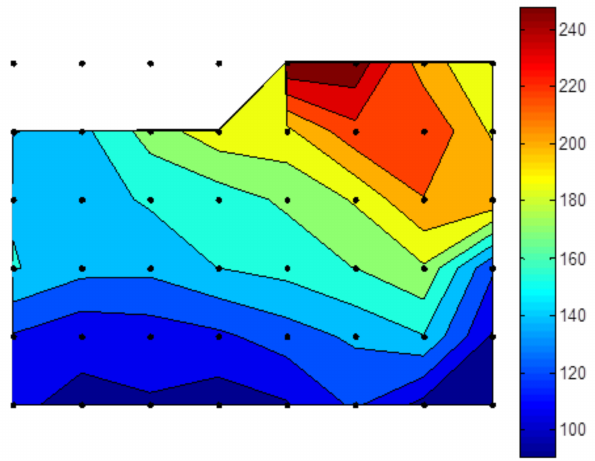
Figure 11. Examples showing the reason why several ratios are used to distinguish abnormal spray shapes: ( a ) Normal spray shape; ( b ) abnormal spray shape of the concentrated dispersion near the spray center.